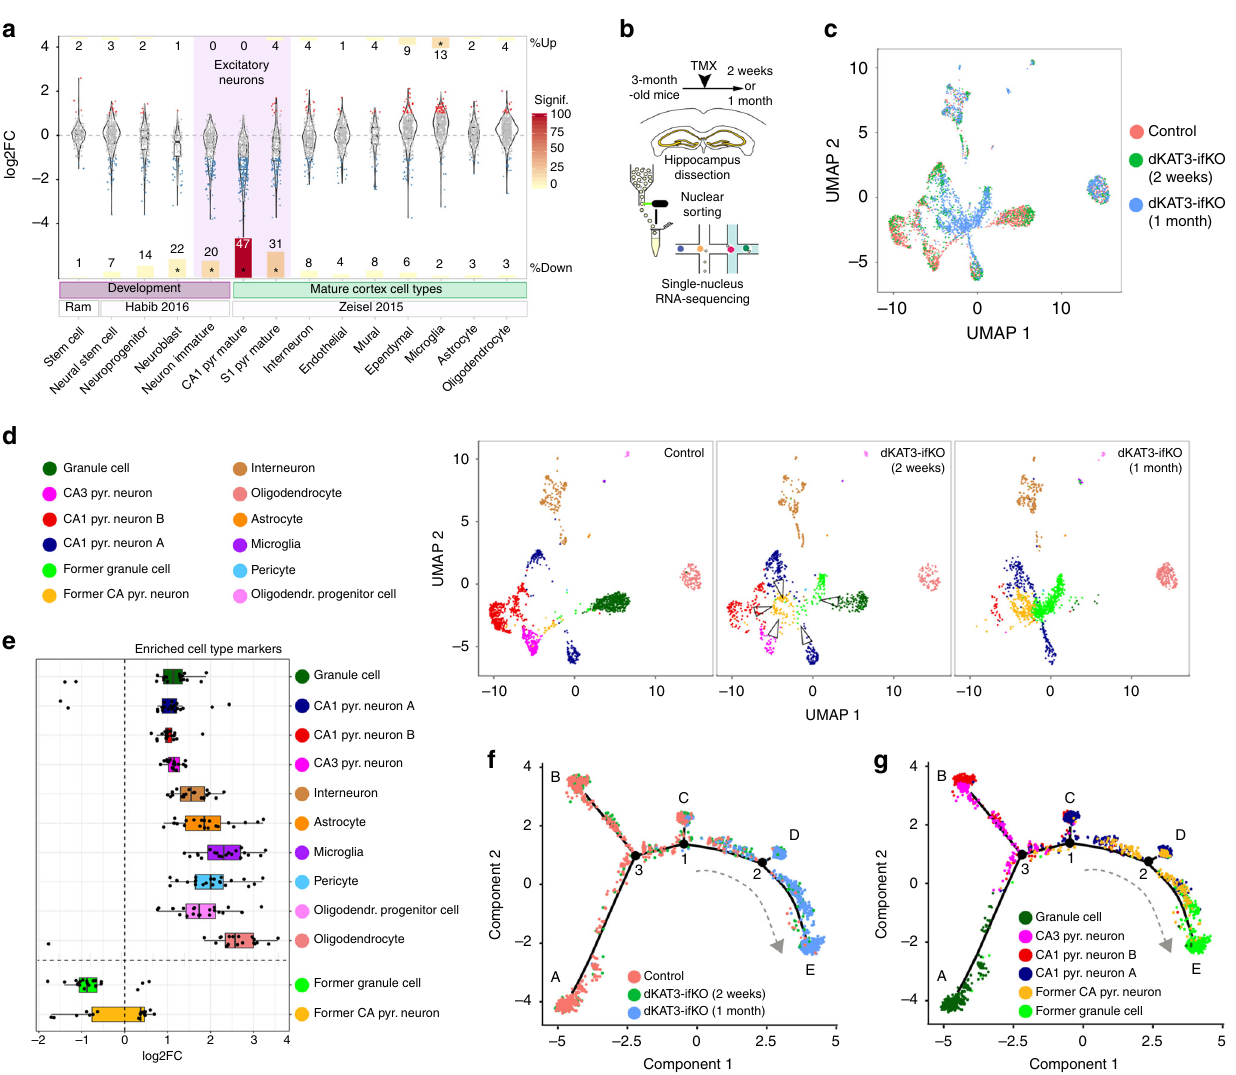
Fig. 3 Cells lacking KAT3 proteins do not die or dedifferentiate, but acquire a novel, molecularly unde fi ned fate. a Violin plots show the change in expression of gene sets associated with stemness 19 and different neuronal differentiation stages 20 during development (purple bar) or with different cell types in the adult mouse cortex 18 (green bar). Each dot represents a single gene. Number of genes tested per cell type: stem cell = 195, neural stem cell = 365, neuroprogenitor = 200, neuroblast = 109, immature neuron = 353, CA1_pyr mature = 371, S1_pyr mature = 251, interneuron = 337, endothelial = 337, mural = 141, ependymal = 420, microglia = 387, astrocyte = 223, oligodendrocyte = 418. Bar sizes are proportional to the percentage of up- or downregulated genes in each gene set as indicated by the number in each bar. Bar colors indicate the signi fi cance of the enrichment ( − log10) in a hypergeometric test for the number of regulated genes. Enrichments with p -values < 5e – 10 are labeled with an asterisk ( p -val Inmature_neuron = 4.82e – 17; p -val CA1_Pyramidal = 2.59e – 101; p -val S1_Pyramidal = 4.69e – 25; p -val Microglia = 3.49e – 15). b Scheme of the single-nucleus RNA-seq experiment. c UMAP plot of integrated analysis of snRNA-seq datasets from the dorsal hippocampus of dKAT3-fKOs and control littermates. d UMAP plots showing identi fi ed populations in the hippocampus of control littermates (left) and dKAT3-ifKO mice 2 (center) and 4 (right) weeks after TMX treatment. Nuclei are colored by their classi fi cation label as indicated. e Boxplots showing the expression of the top 20 markers for the 10 cell types detected in the hippocampus of control mice and the two new clusters detected in dKAT3-ifKO mice 1 month after TMX (Supplementary Data 2). Whiskers lengths are 1.5 the interquartile range from the box. Abbreviations: Pyr, pyramidal; Oligodendr, oligodendrocyte. f , g Single-nucleus trajectory analysis of hippocampal excitatory neurons reveals cell state-transitions toward a non-functional interstate deadlock. Nuclei are colored by experimental condition ( f ) or cluster subpopulation ( g ) as indicated in the legends. Loss of dKAT3s caused the progressive relocation of the cells from the root in the branches A, B, and C (expressing markers for different types of excitatory neurons) towards the outcome in branches D and E that are populated by the type of cells described in ( e ) that do not express distinctive markers. Source data for graphs in panels ( a ) and ( e ) are provided as a Source data fi